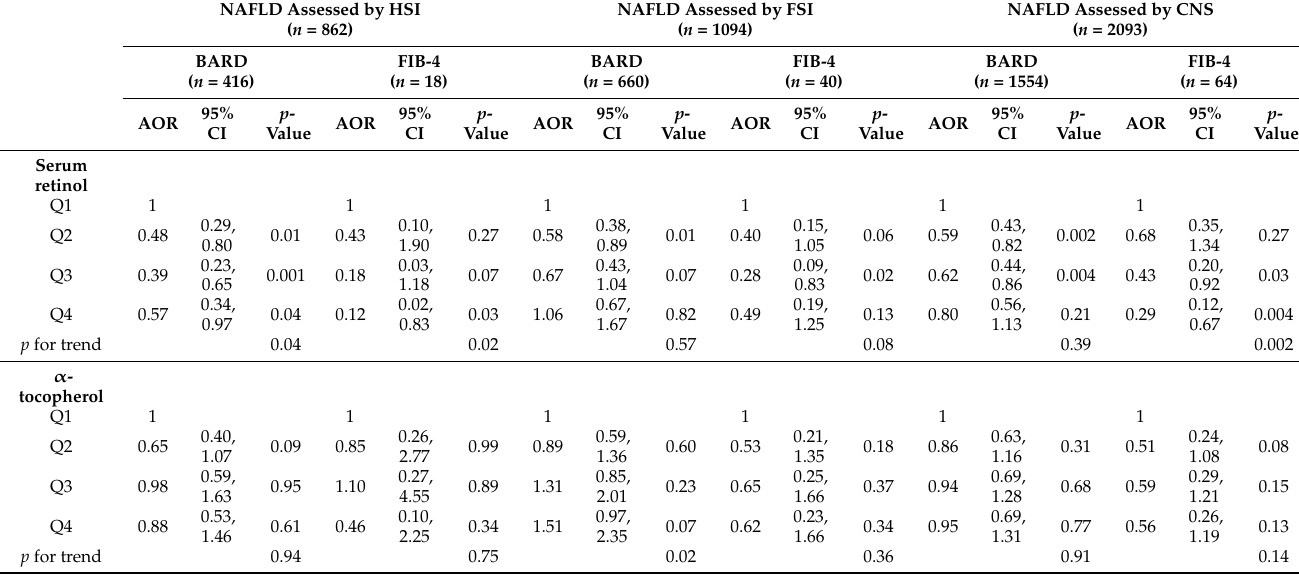
Table 5. AORs * with 95% CIs for association of serum retinol and α -tocopherol with advanced fibrosis assessed using BARD and FIB-4. NAFLD Assessed by HSI ( n = 862)